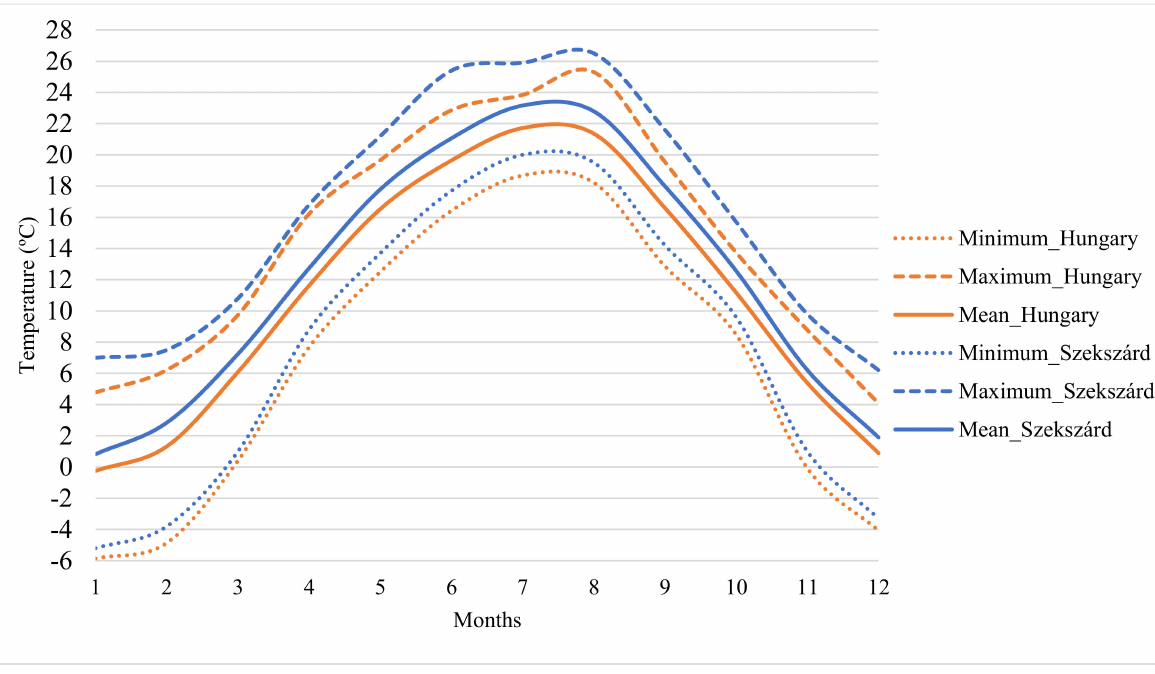
Figure 6. Forty-year average temperature ( ◦